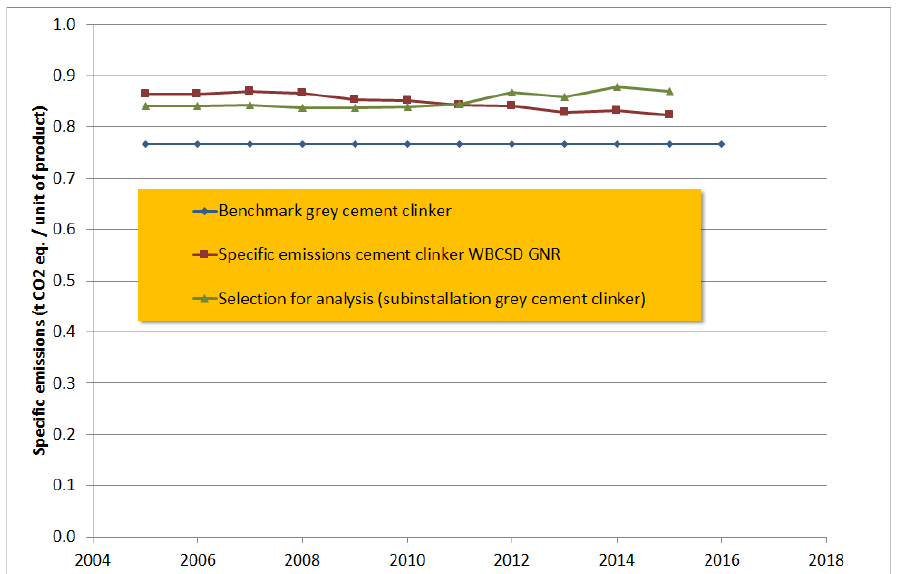
Figure 6. Specific emissions of cement clinker compared to the benchmark (straight line). Source: WBCSD database [26]; Benchmark for cement clinker [3]; own calculation [19].